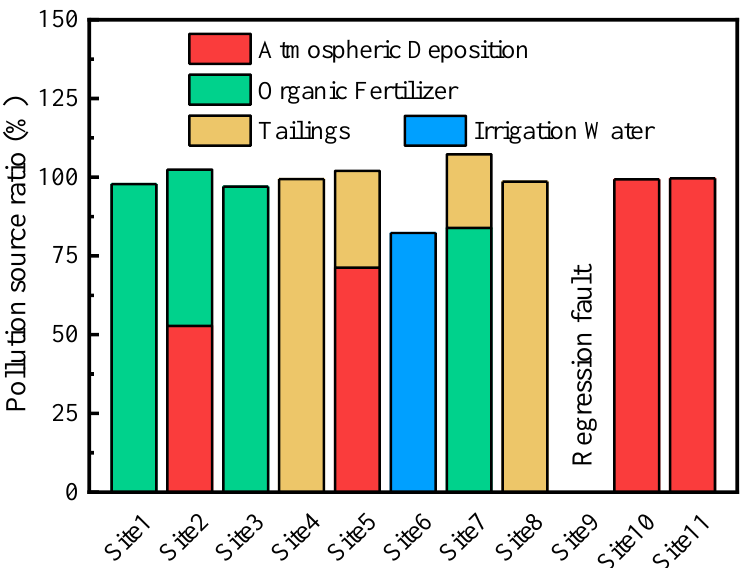
0.948 Figure 6. Contributions of different sources of pollution to different sites, determined using multiple linear regression.